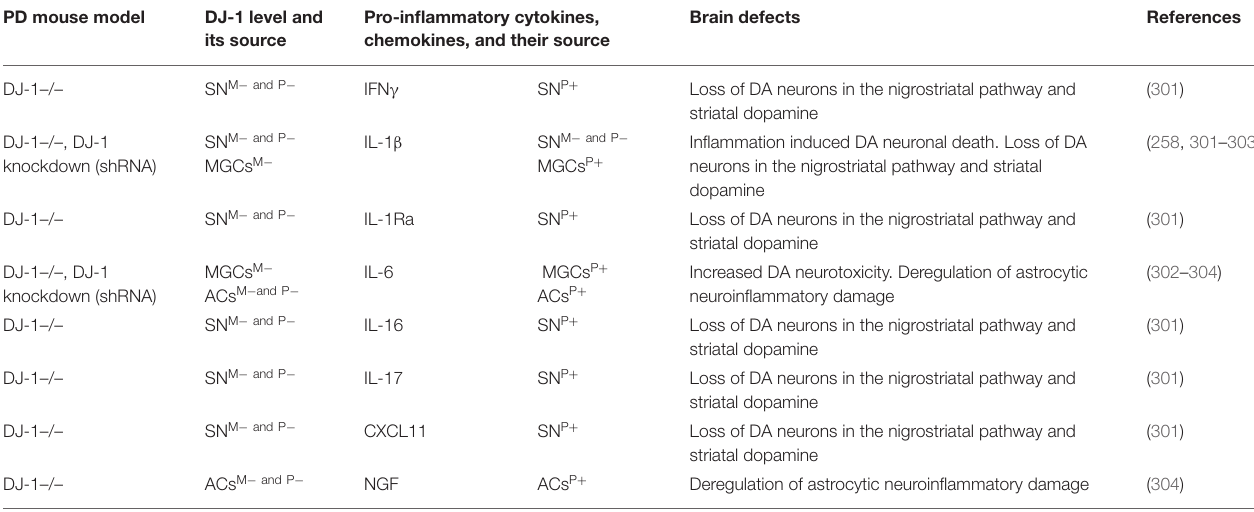
TABLE 7A | Cytokines and their source in the mouse model of PARK7 PD.